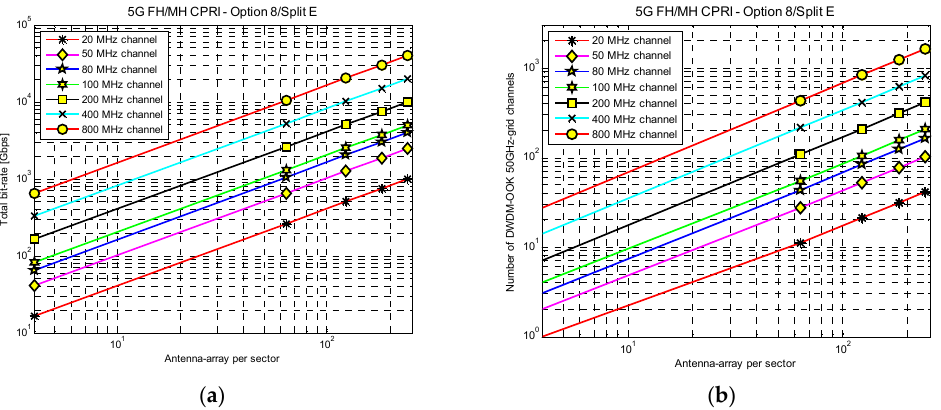
Figure 9. Calculation results of optical resources needed to connect 4-sector gNB-DU/RRH to optical FH/MH as a function of antenna elements number of massive-MIMO array: ( a ) total bit-rate for radio BB channels digitized to CPRI format (LC = 66/64) – 3GPP—Option 8/CPRI Forum—Split E (Figure 7a,c); ( b ) number of DWDM-OOK 50GHz-grid channels for radio BB channels digitized to CPRI format (LC = 66/64) − 3GPP—Option 8/CPRI Forum—Split E (Figure 7a,c).